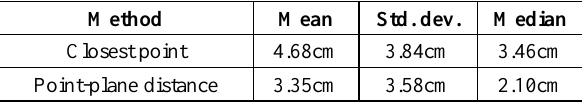
Table 6. Accuracy assessment results using the ITS local coordinate system and based on distance comparison method.